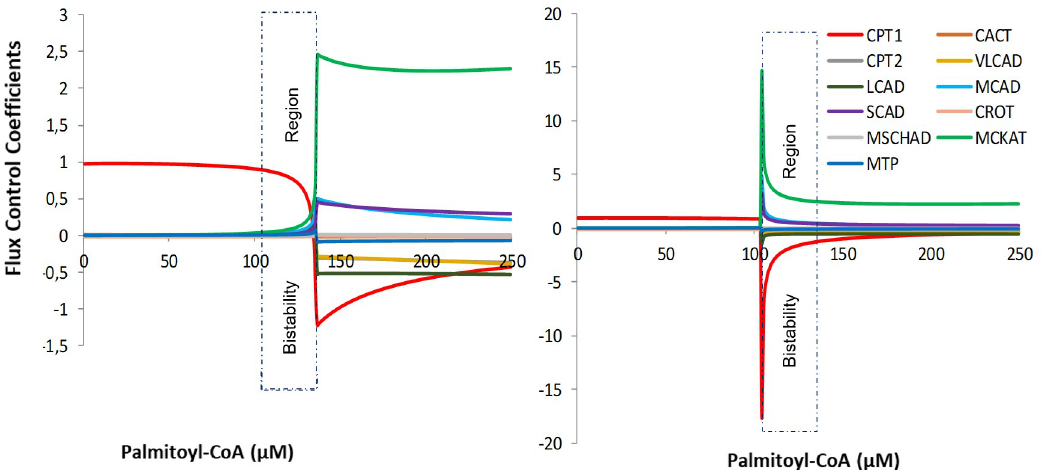
Fig 6. Flux control coefficients and bistablity in mFAO model. Flux control coefficients of 11 enzymes for (right) increasing supply of palmitoyl-CoA concentrations and (left) decreasing supply of palmitoyl-CoA concentrations.